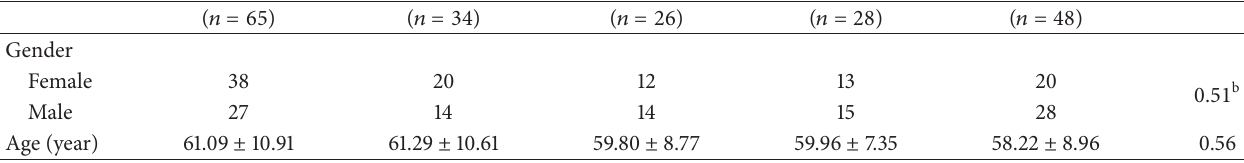
Table 1: Age and gender distribution of patients according to stages.